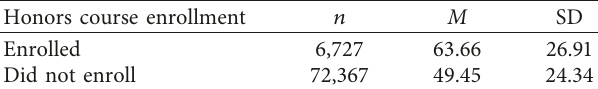
Table 4: Descriptive statistics for student-faculty interaction benchmark scores by honors course enrollment status.